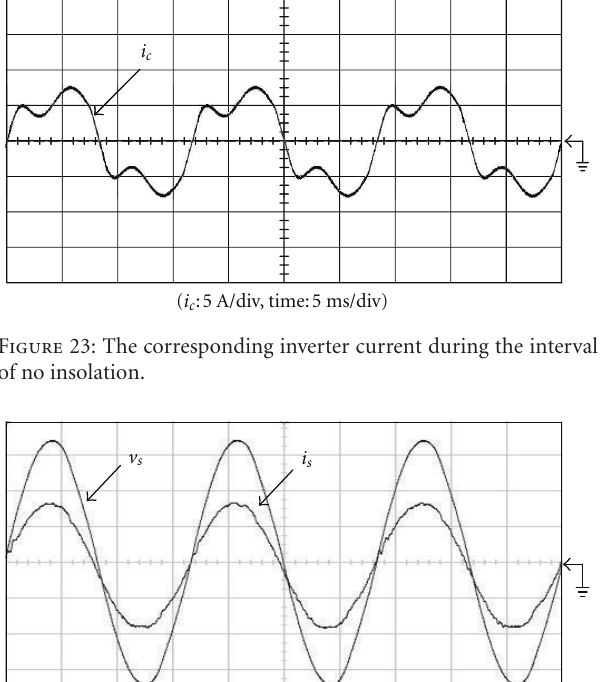
Figure 20: Filtered line current and line voltage during the interval of low insolation.